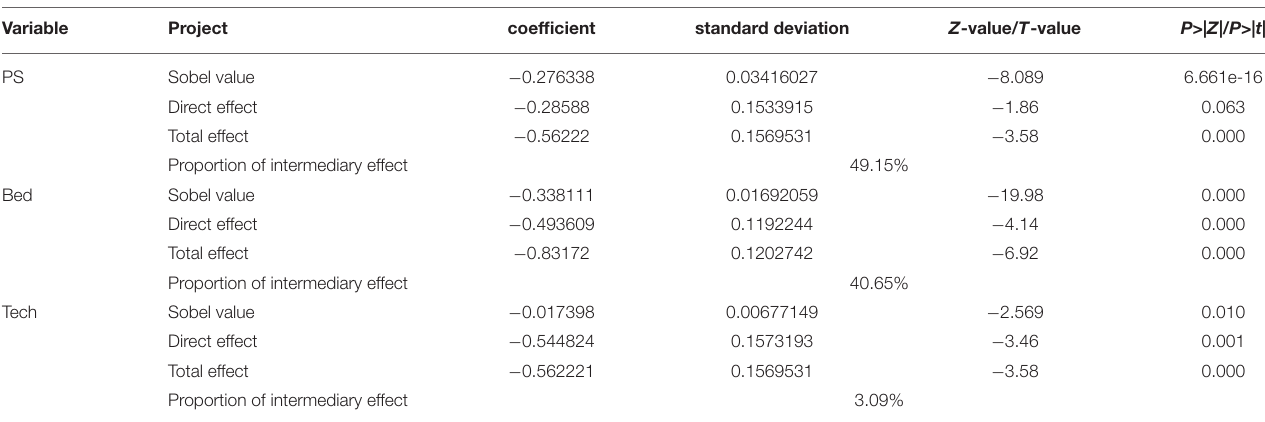
TABLE 6 | Sobel test